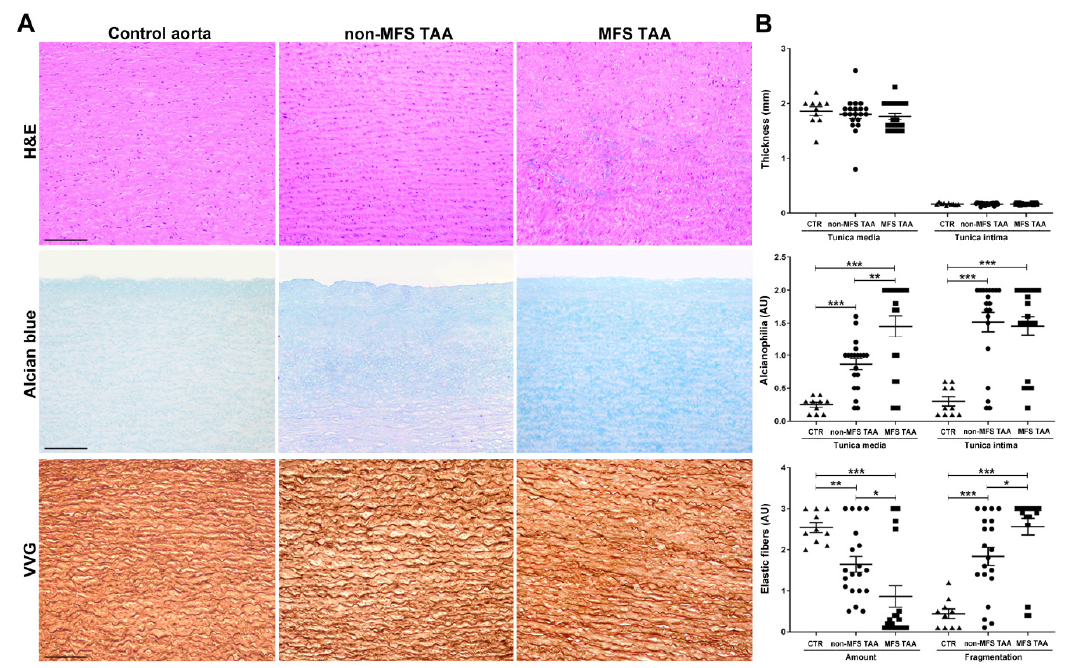
Figure 1. Increased alcianophilia and elastic tissue remodeling characterize Marfan syndrome (MFS) thoracic aortic aneurysm. ( A ) Representative aortic media sections stained with hematoxylin and eosin (H&E) show greater degeneration with accumulation of basophilic material in the tunica media of MFS thoracic aorta aneurysm (TAA). Alcian blue staining shows increased accumulation of alcianophilic material in MFS compared to non-MFS TAA and control aorta. Verhoeff–Van Gieson (VVG) staining documents greater loss and fragmentation of elastic fibers and a more irregular arrangement in the tunica media of MFS compared with non-MFS TAA and control aorta. Scale bars equal to 150 μ m. ( B ) Bar graphs of morphometric evaluations concerning intimal and medial thickness, alcianophilia and elastic tissue loss and fragmentation in non-MFS and MFS TAA and control aortas. MFS TAA ( n = 20), non-MFS TAA ( n = 20) and control aorta ( n = 10). Average are reported as means ± SEM; * p < 0.05; ** p < 0.01; *** p < 0.001; estimated by t -test. Abbreviations: AU, arbitrary units.